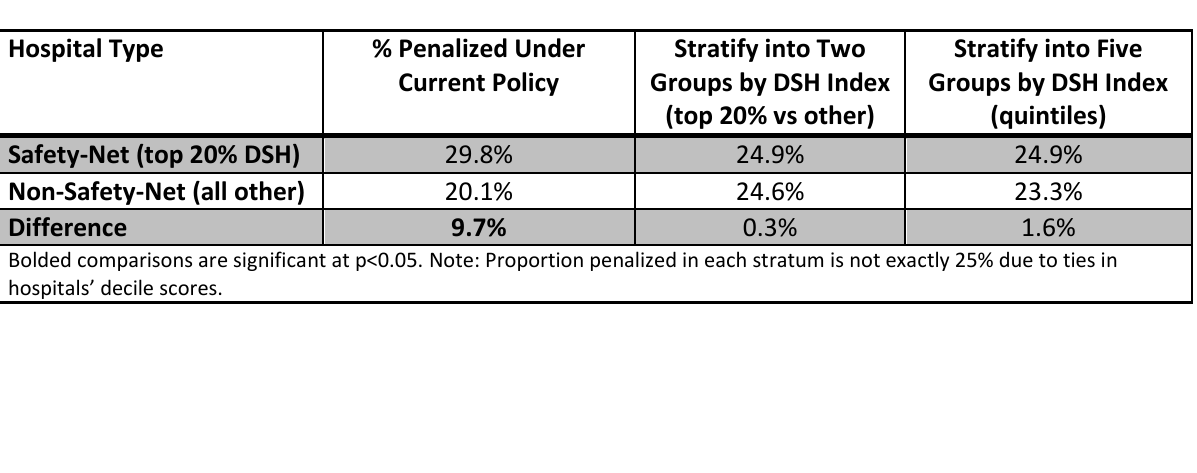
Table 6.17: Percent Penalized After Stratification into Two or Five Groups based on DSH